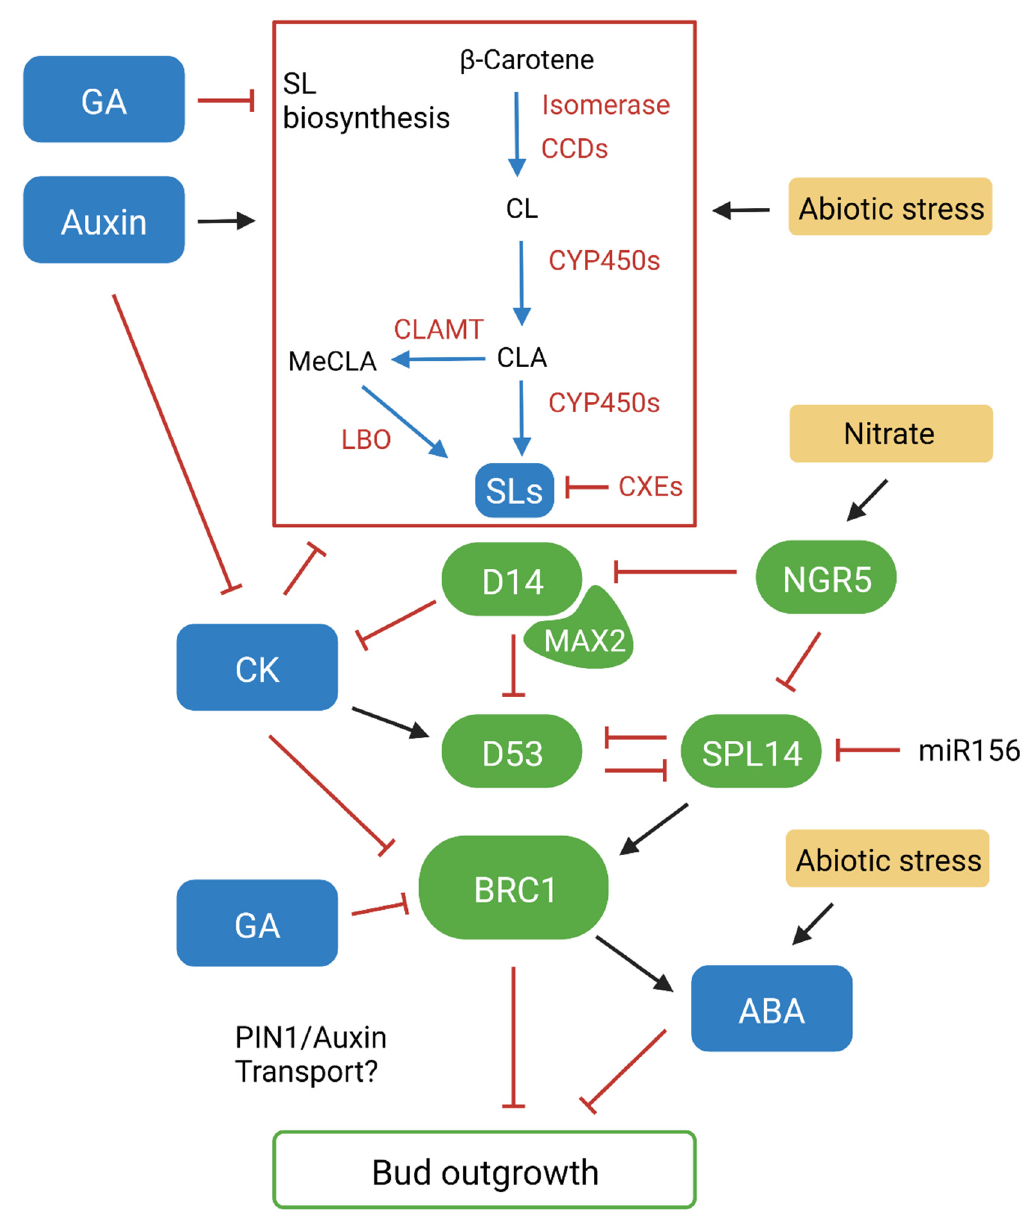
Figure 1. A complex signalling network influences branching decisions by promoting or repressing bud outgrowth. BRANCHED1 (BRC1) plays a central role within this network, acting within buds to repress outgrowth. Auxin and SL act as inducers of BRC1 while cytokinin (CK) and gibberellin (GA) act to repress it. Abscisic acid (ABA) can also act as a negative regulator of bud outgrowth downstream of BRC1. Blue arrow, conversion; black arrow, promotion effect; red line, inhibition effect; green element, proteins/transcription factors; blue element, phytohormones; yellow element, abiotic condition. Created with BioRender.com.